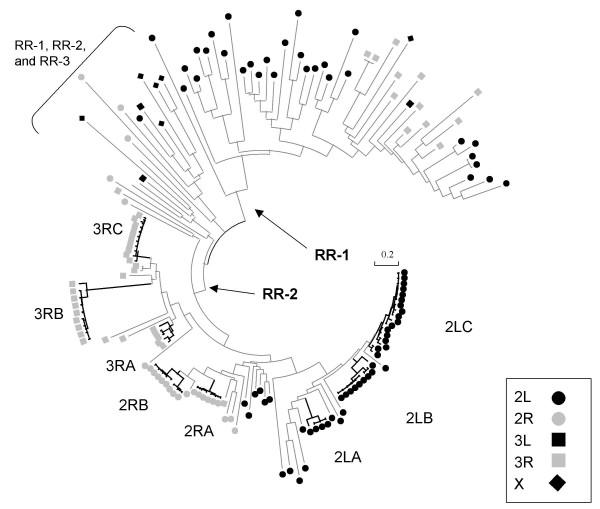
Topology of the neighbor-joining tree of all An. gambiae CPR genes. Gene names are omitted here for clarity. Detailed phylogenies of the RR-1 and RR-2 clades are presented as Figures 7 and 8. Distances are based on the amino-acid sequence of the aligned and weighted R&R Consensus as described in the text. We used the JTT exchange matrix [49] as implemented in MEGA3 [48]. The core group of RR-1 and RR-2 proteins and an intermediate group of RR-1, RR-2, and RR-3 proteins are marked. The sequence clusters defined in the text are also marked. Symbols represent the chromosome arm on which each gene is located. The three without symbols have not been placed on a chromosome.